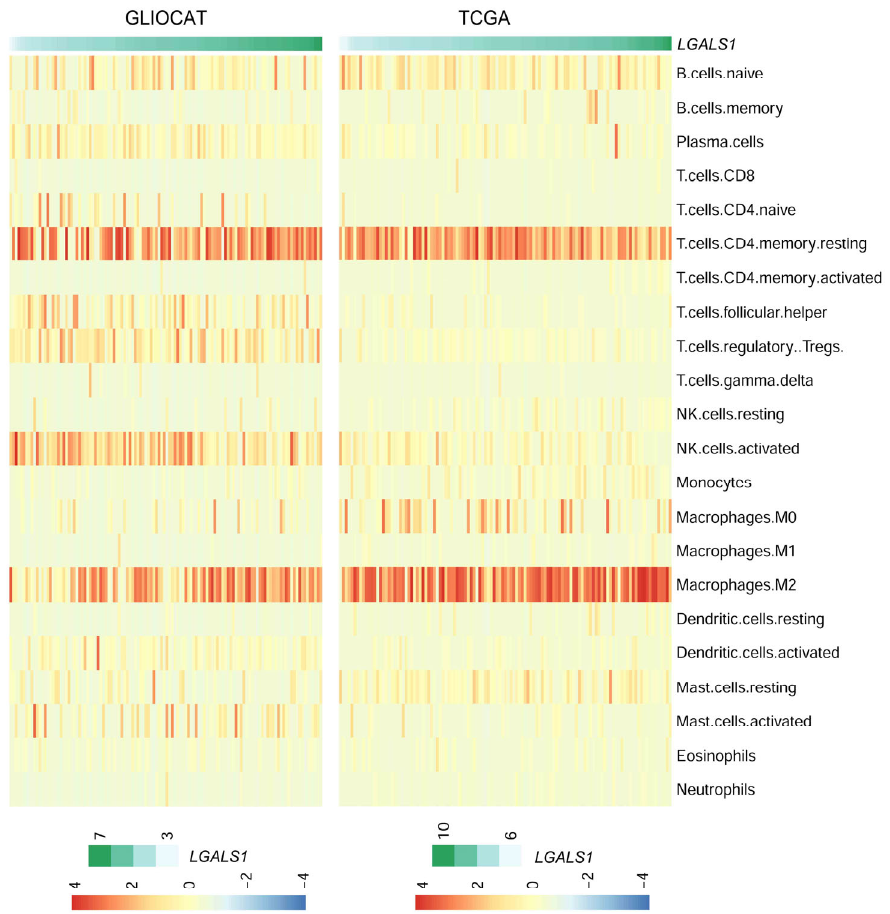
Figure 6. Cell type CIBERSORT deconvolution in GLIOCAT and TCGA cohorts. Heatmap showing CIBERSORT (scaled) absolute values of the LM22 immune signature for the GLIOCAT and TCGA cohorts. Samples (columns) are ordered by increasing LGALS1 expression.